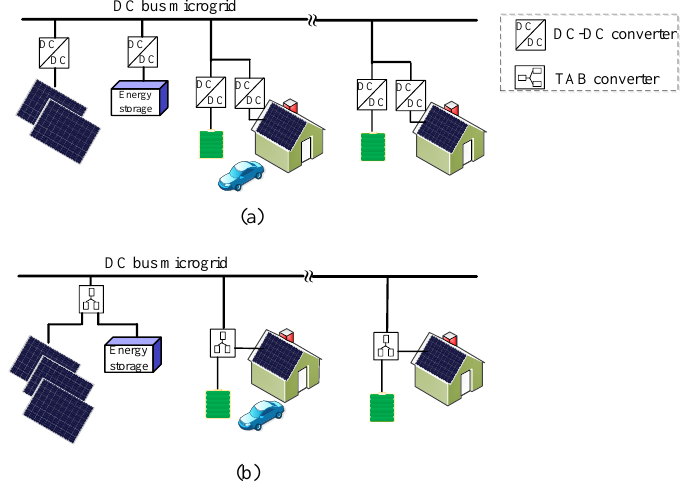
Figure 10. Comparison of DC bus microgrid using the TAB converter and the conventional DC-DC converter. ( a ) The system uses the conventional DC-DC converter. ( b ) The system uses the TAB converter.